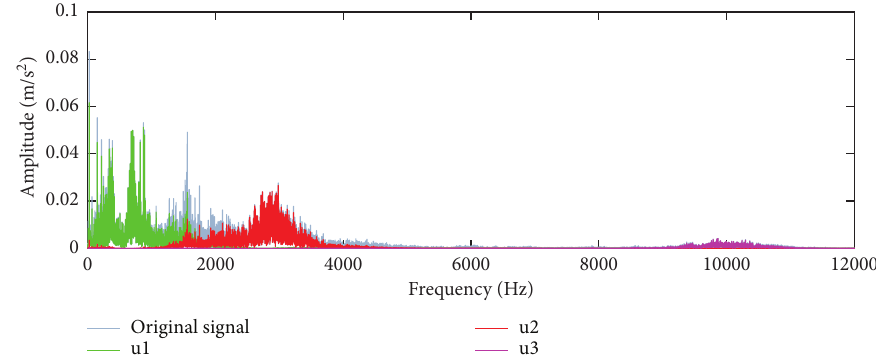
Figure 30: Experimental signals of case 2: the spectrum of each component based on IPAVMD.